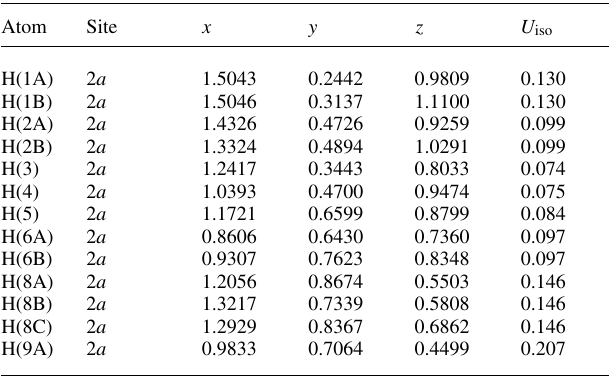
Table 2. Atomic coordinates and displacement parameters (in Å 2 ) . Table 2.